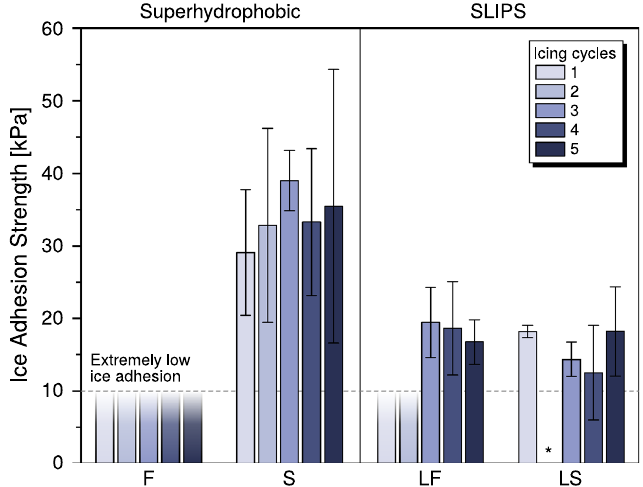
Figure 2. Ice adhesion results for all samples and icing cycles. Error bars are equal to one standard deviation. It was not possible to definitively assign a value to sample LS at its 2nd icing cycle (marked with an